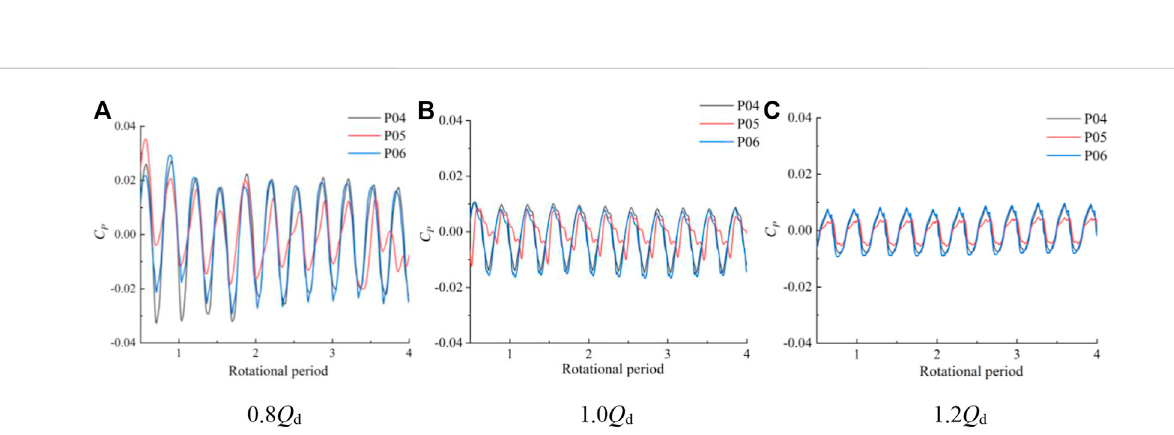
Time domain diagram of the impeller inlet monitoring points at different fl ow rate conditions.